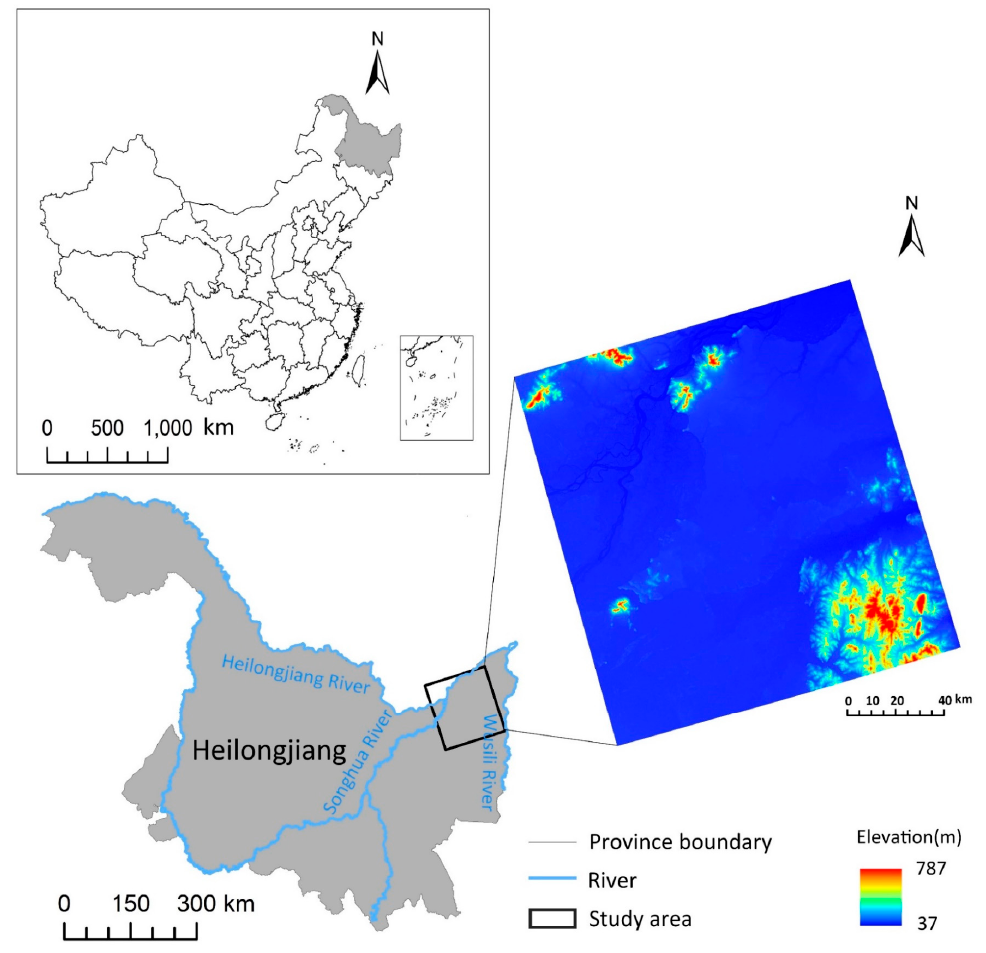
Figure 1. The location of the study area and its digital elevation model (DEM). The DEM is from Shuttle Radar Topography Mission (SRTM) 90 m Digital Elevation Data Version 4, obtained from http://www.srtm.csi.cgiar.org. Main rivers, the county boundary and Landsat scene extent (path/row 114/27) are highlighted.